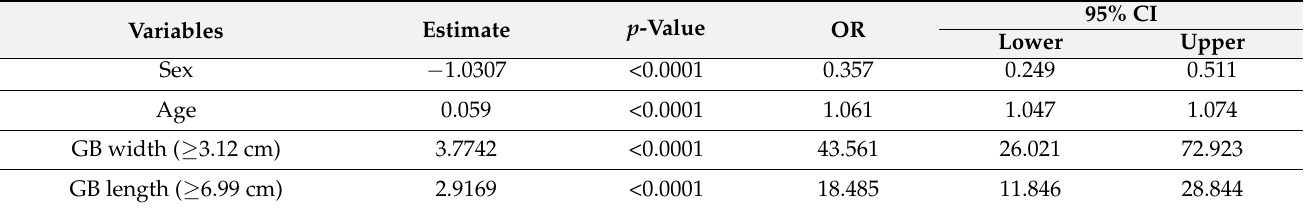
Table A1. Univariable Analysis for CT Findings and Clinical Data Affecting Acute